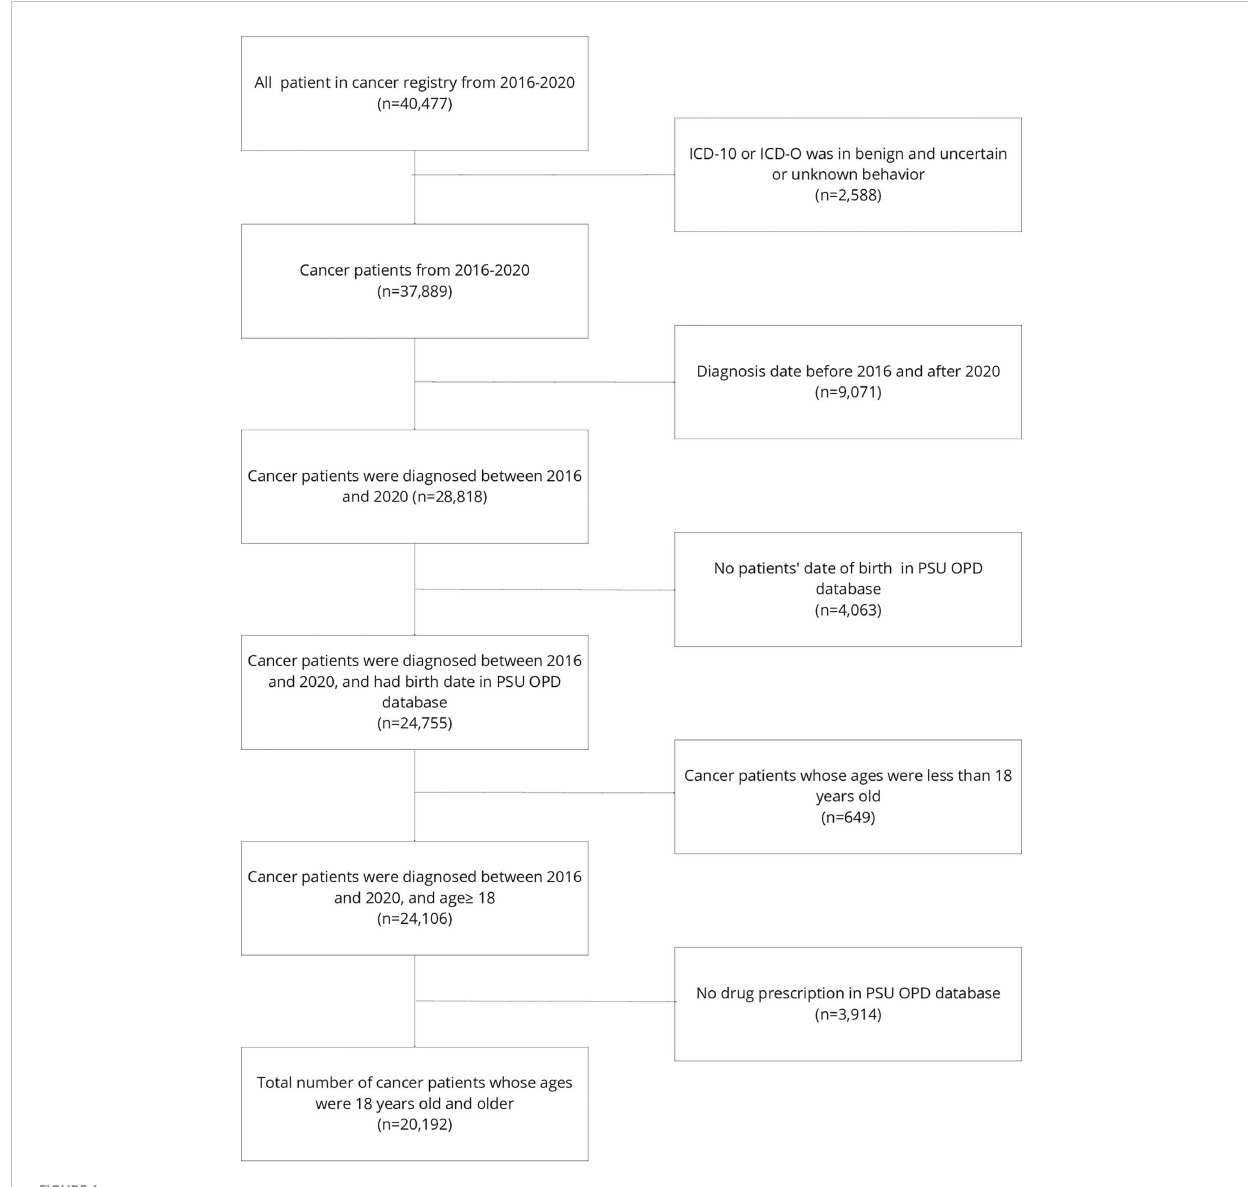
FIGURE 1 Participant fl ow